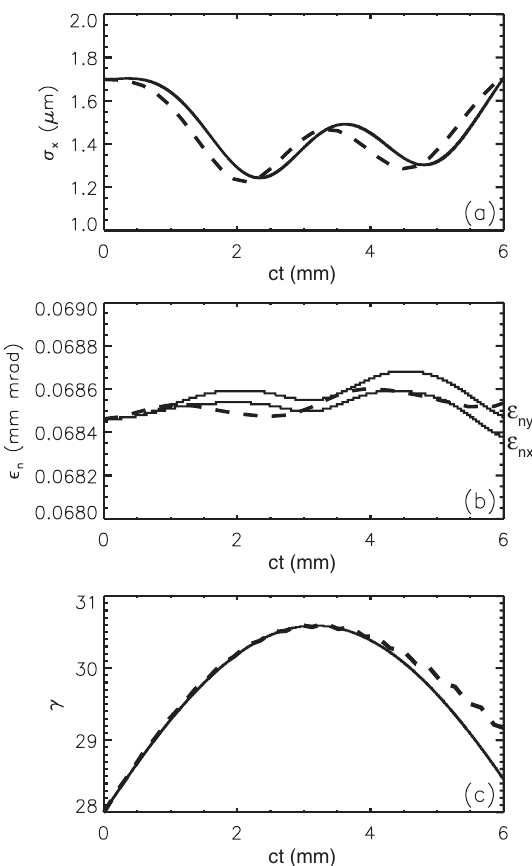
FIG. 10. Comparison between the PIC code VORPAL (dashed line) and the particle tracking code GPT (solid line) showing the evolution of a test electron beam (a) spot size, (b) emittance (in both transverse directions x and y for GPT), and (c)